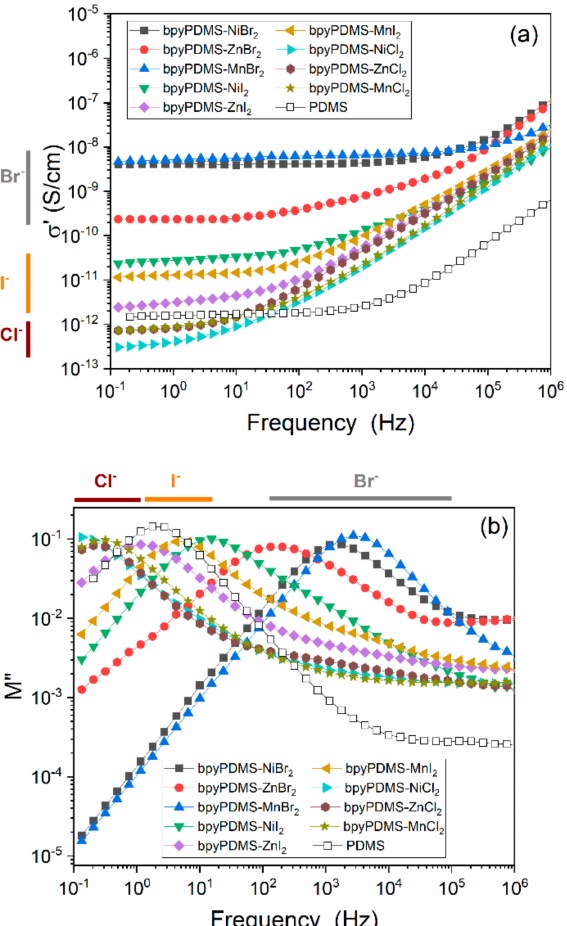
Figure 6. ( a ) Real part of conductivity ( σ ’) and ( b ) imaginary part of modulus (M”) plots of PDMS and all investigated organometallic compounds vs. frequency at 323